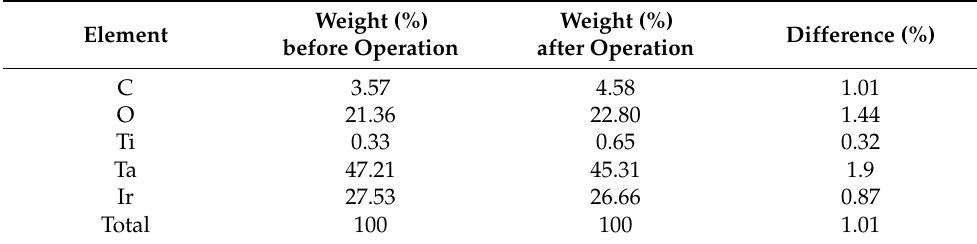
Table 2. The percentage of elements before and after electrode